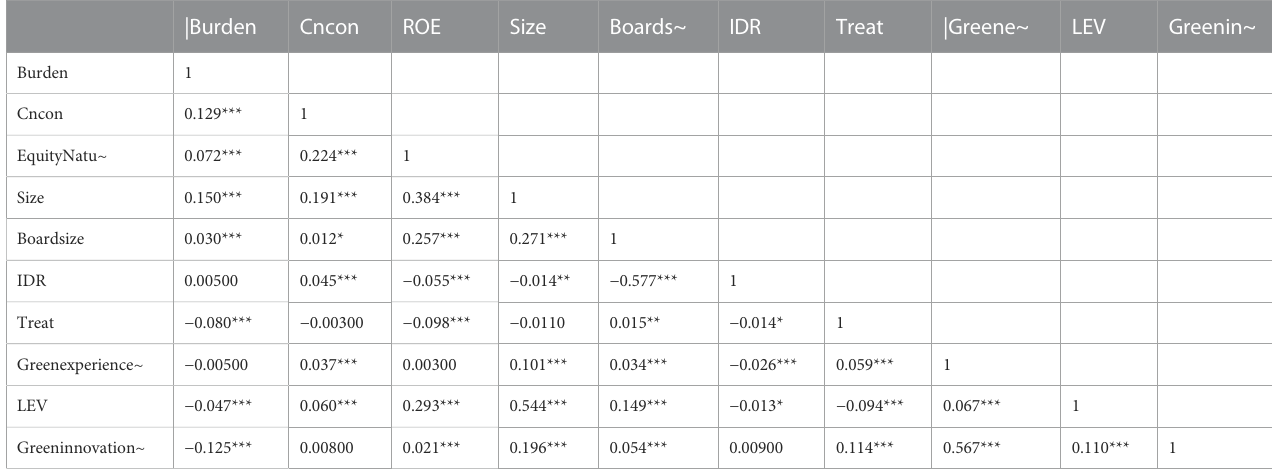
TABLE 3 Pearson correlation coef fi cient matrix.